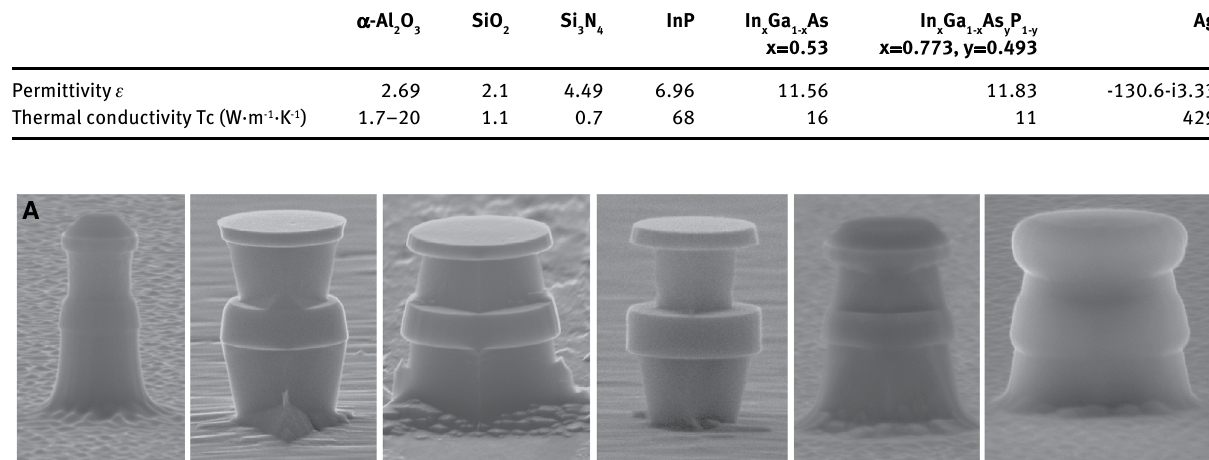
COOH etching alone, 3 O deposition. 2 3